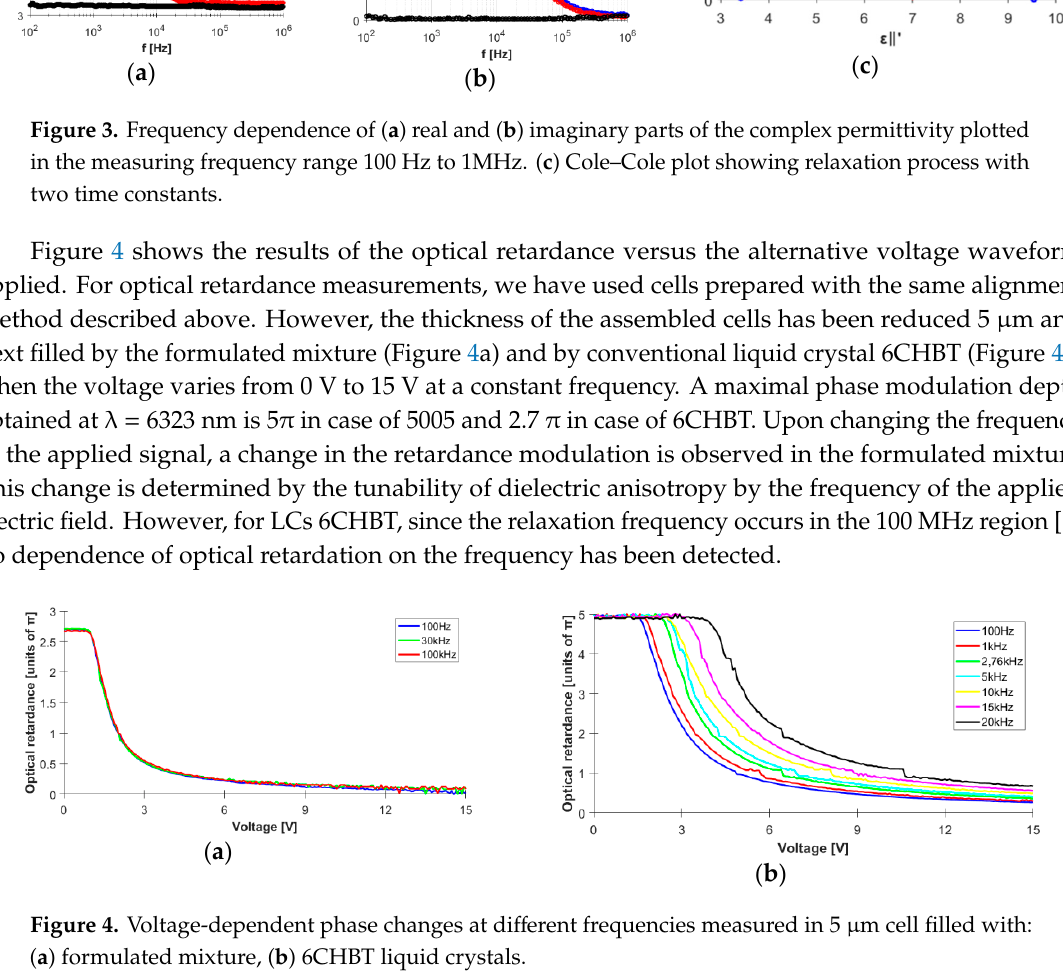
Figure 3. Frequency dependence of ( a ) real and ( b ) imaginary parts of the complex permittivity plotted in the measuring frequency range 100 Hz to 1MHz. ( c ) Cole–Cole plot showing relaxation process with two time constants.